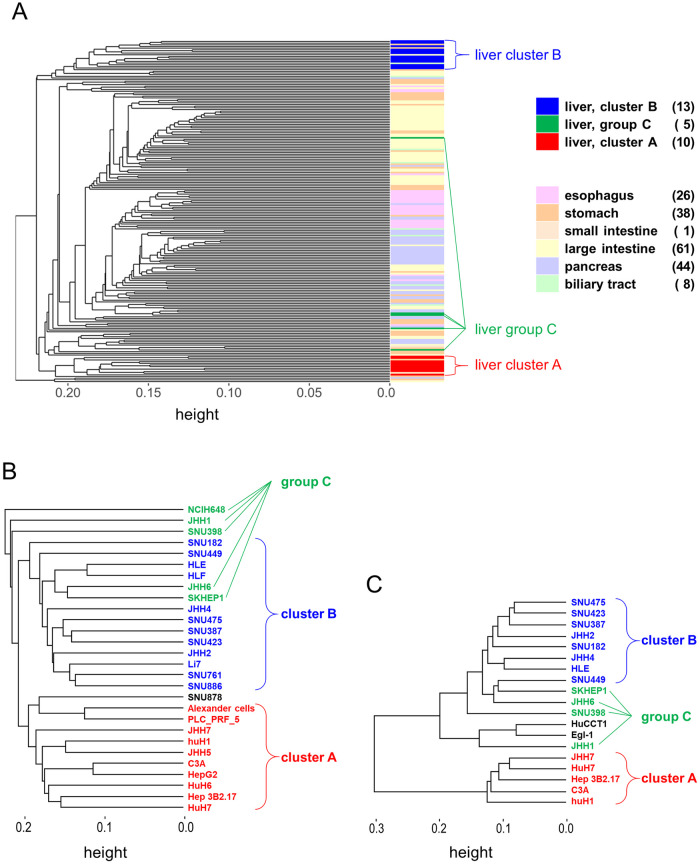
Expression-based unsupervised hierarchical clustering.(A) The expression data of 206 digestive cancer cell lines from the Cancer Cell Line Encyclopedia (CCLE) were analyzed. (B) The 28 liver cancer cell lines obtained from CCLE were extracted and analyzed again. (C) Nineteen liver cancer cell lines in another dataset from the Catalogue of Somatic Mutations in Cancer (COSMIC) were clustered.